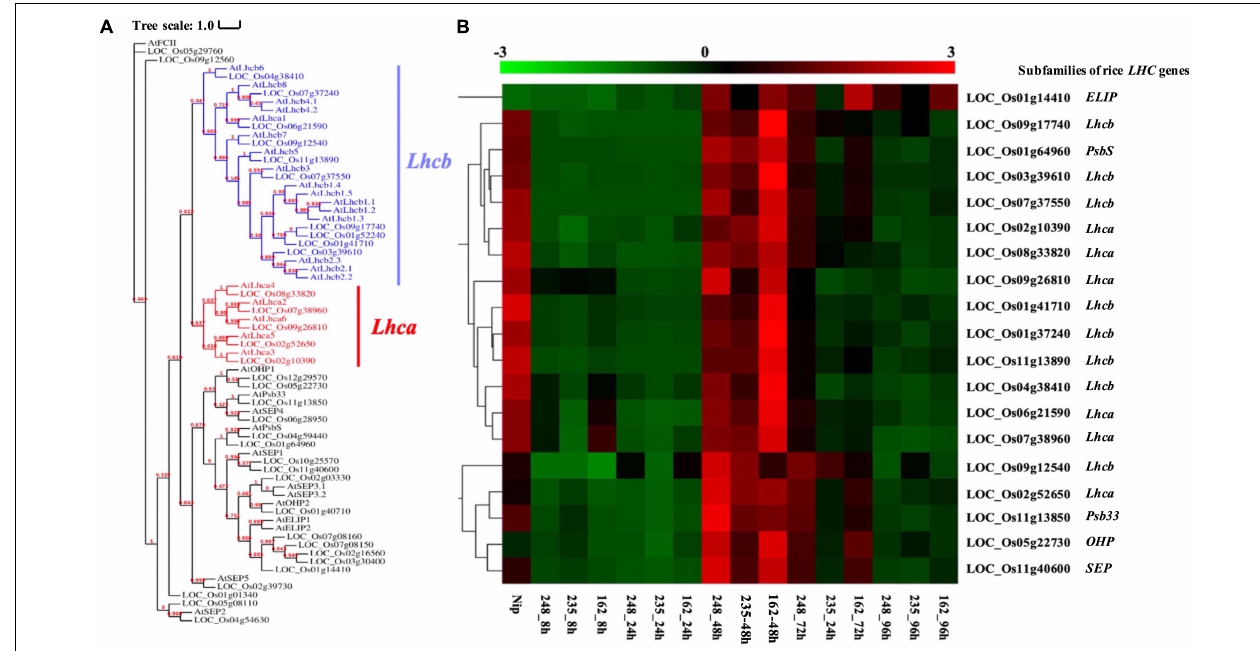
FIGURE 7 | Analysis of O. sativa light-harvesting chlorophyll a/b-binding proteins (LHCs) superfamily. (A) Phylogenetic tree of LHCs proteins identified in O. sativa and Arabidopsis thaliana Maximum likelihood tree, with 1,000 bootstraps (values displayed per branch). Subfamilies of Lhcb and Lhca were marked in blue and red color. (B) RNAseq Expression level of Lhcb and Lhca genes during interacting with M. oryzae . The LHCs subfamily and their homologous genes in Arabidopsis thaliana were listed on the right side of the